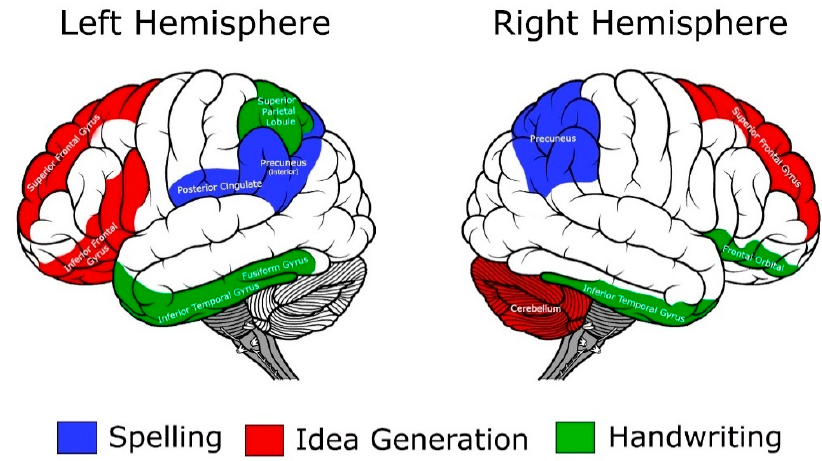
Figure 2. A composite of approximate brain regions associated with writing